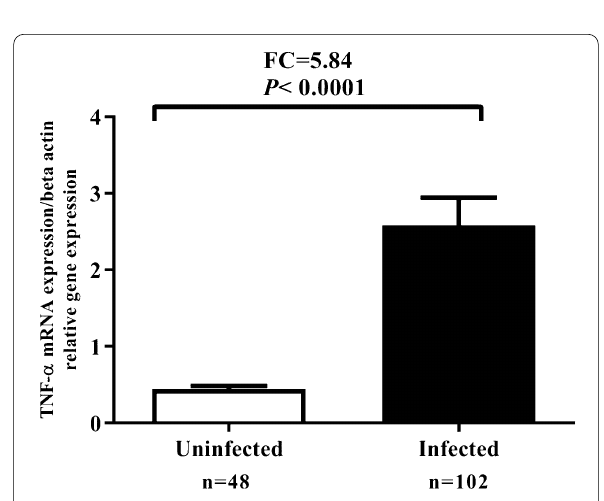
Fig. 2 Comparison of TNF‑α mRNA expression in patients with or without H. pylori ‑infection. TNF‑α expression was significantly increased in H. pylori- infected individuals in comparison with uninfected patients. P < 0 .05 was considered statistically significant by independent samples t‑test (N number and FC fold = =